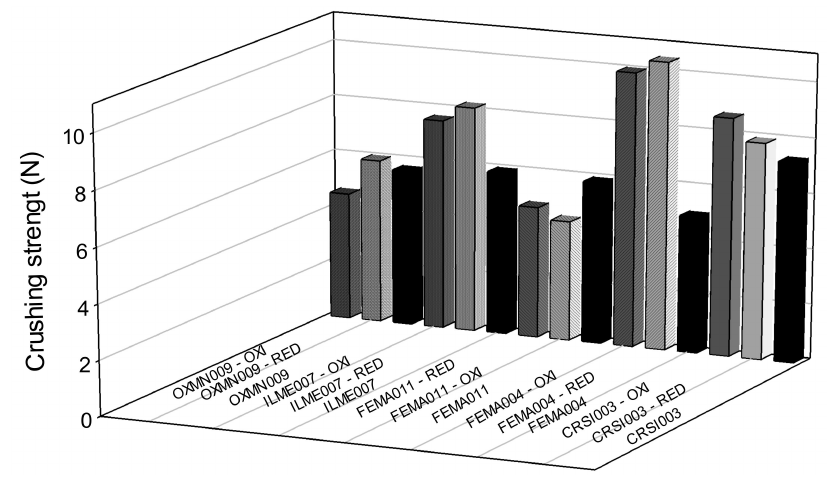
Figure 2. Crushing